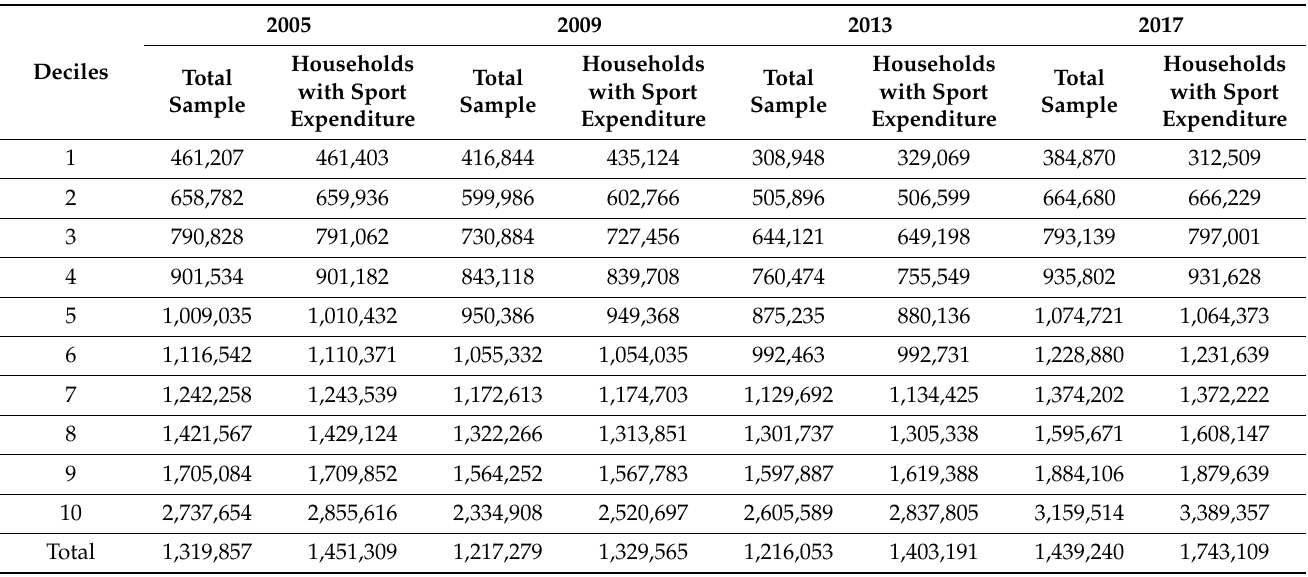
Table 2. Average net income per capita in the total sample and in the sub-sample of households with sports expenditure (HUF).